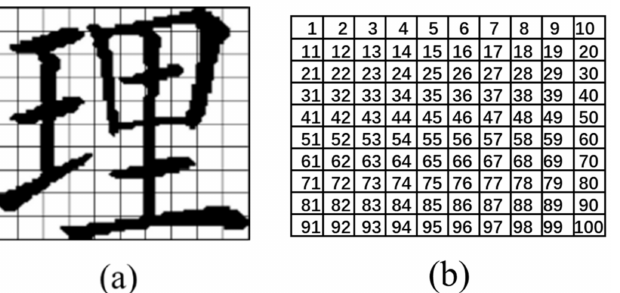
Figure 8. ( a ) The Chinese character “ 理 ” (means “handle”) to be processed. ( b ) Schematic illustration of 100-area